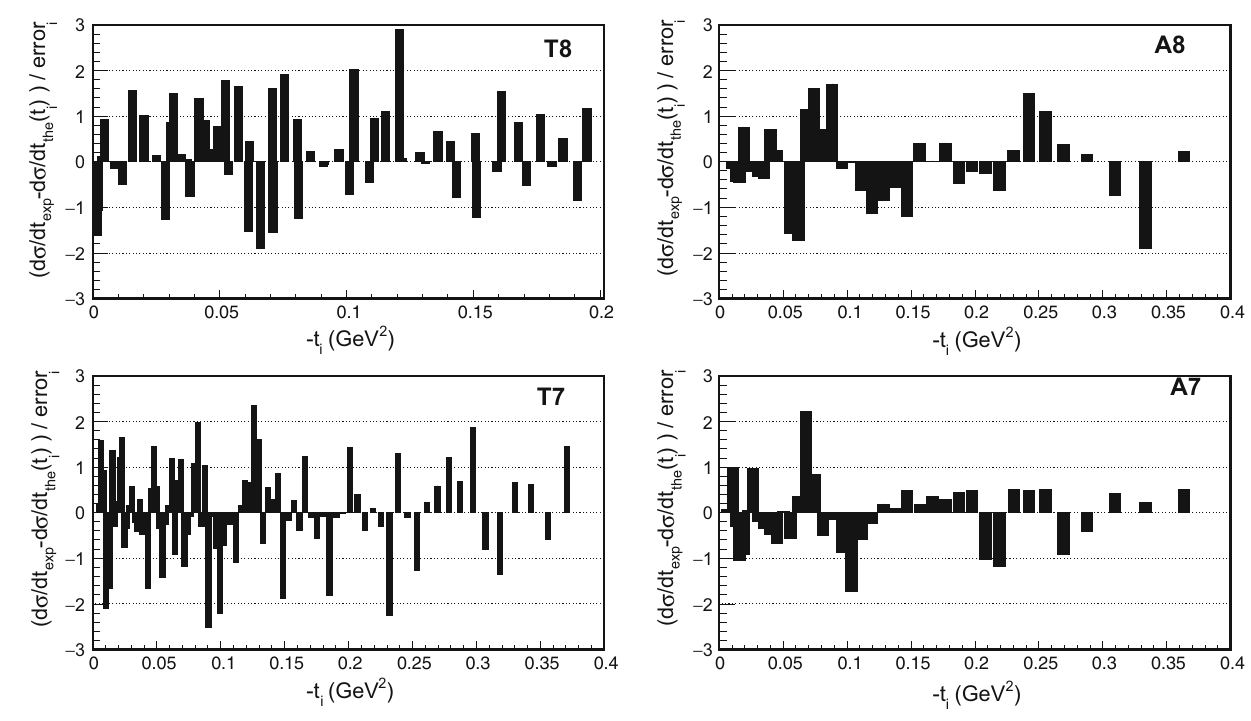
Fig. 7 Pull plots of the analysis of the measurements. The y axis in a pull plot is defined as ( d σ/ d t i exp -d σ/ d t the ( t i ))/ error i , where d σ/ d t i exp is the experimental value at some t i with error i and d σ/ d t the ( t i ) is the theoretical value calculated at t i . According to the maximum likelihood